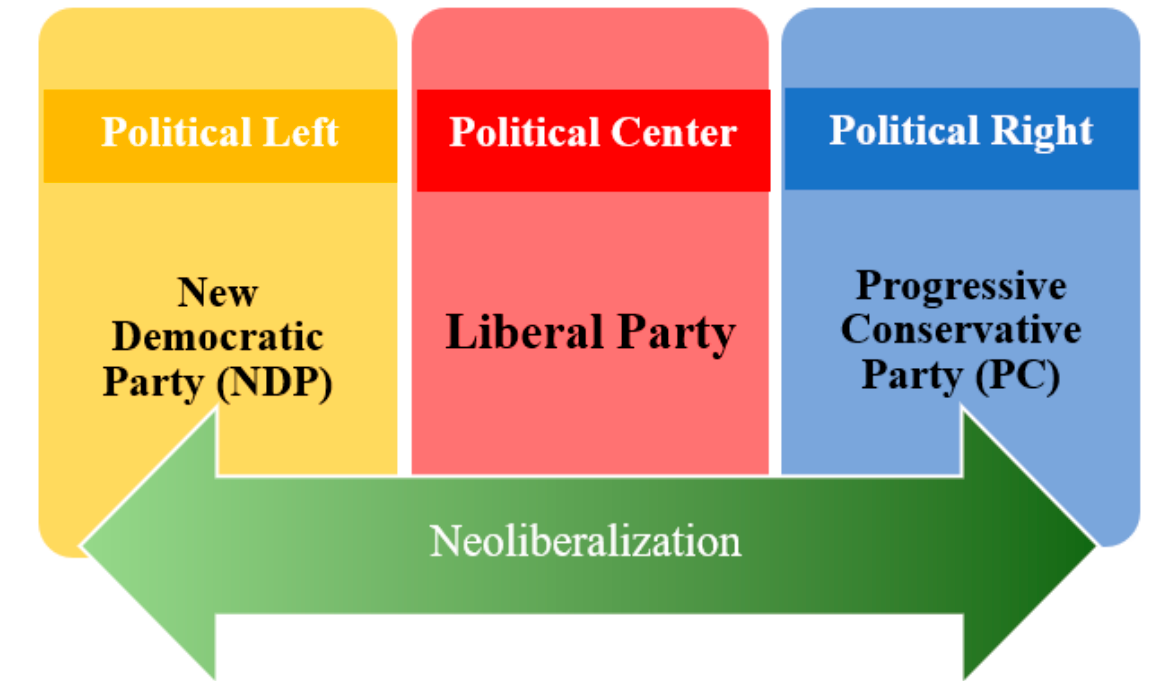
Figure 1. This graphic shows the political spectrum of the three major political parties in Ontario with the NDP falling on the political left, Liberal party positioned at the center and PC party on the right. The green arrow gradient is indicative of the neoliberalization of each party, with the dark end representing a stronger adherence to neoliberal principles.